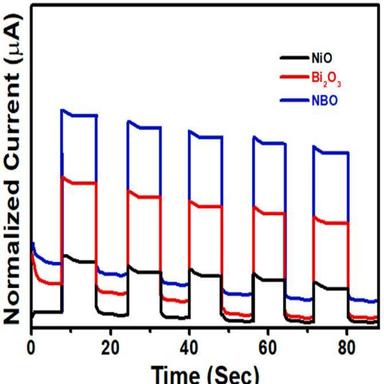
Control tests of selective photodegradation of MB and MO dyes with the addition of some radical scavengers: tertbutyl alcohol (TB, scavenger for •OH radicals), K2S2O8 (KSO forager for e-s) and ammonium oxalate (AO, forager for h + s) over the optimal NBO under visible light treatment.